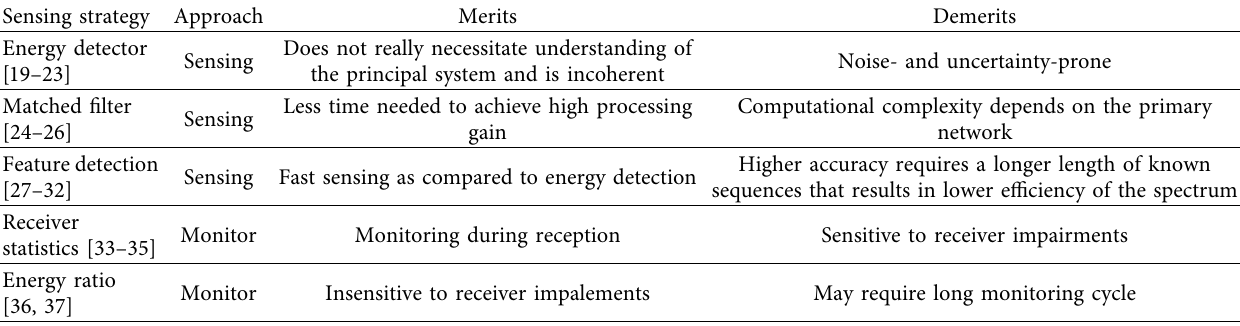
Table 2: Performance comparison of narrow band spectrum sensing